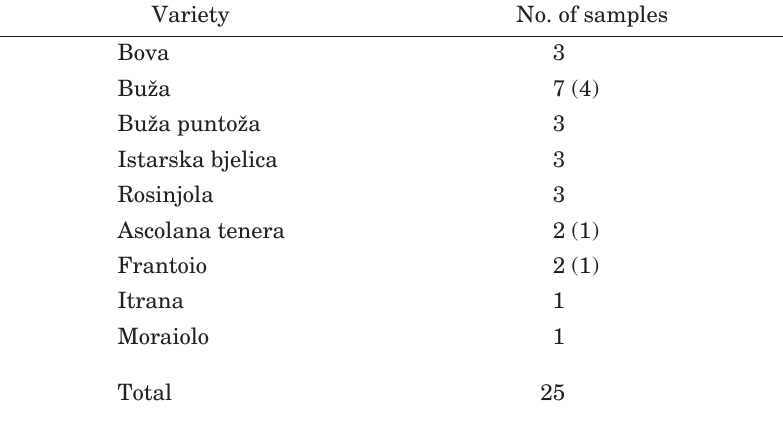
Table 1. Plant material assayed for presence of viruses in this study. The numbers in parentheses indicate positive